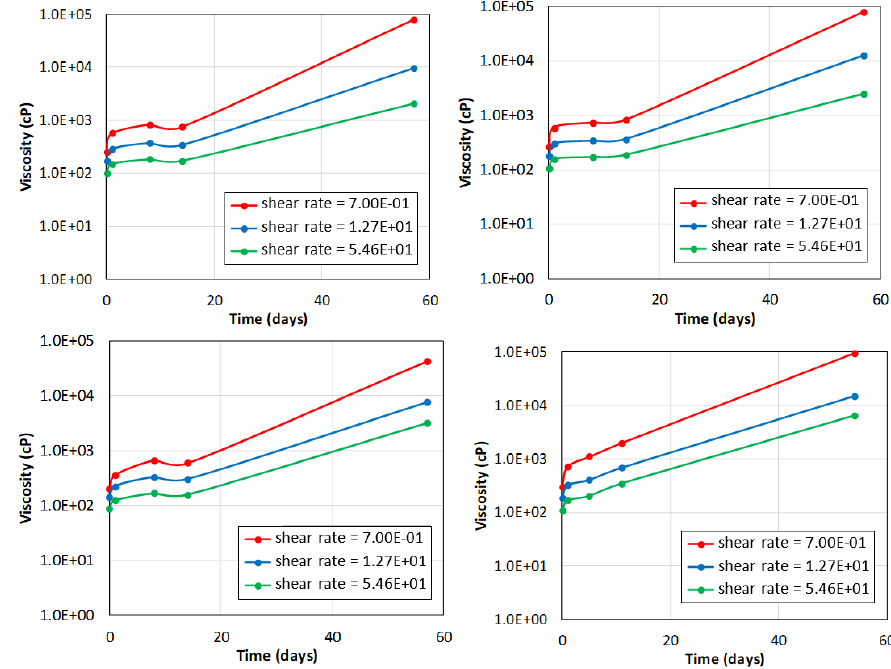
Figure 5. Polymer/PEC solutions aged at 80 °C. ( Upper left ) Series 17 samples. ( Upper right ) Series 18 samples. ( Lower left ) Series 19 samples. ( Lower right ) Series 20